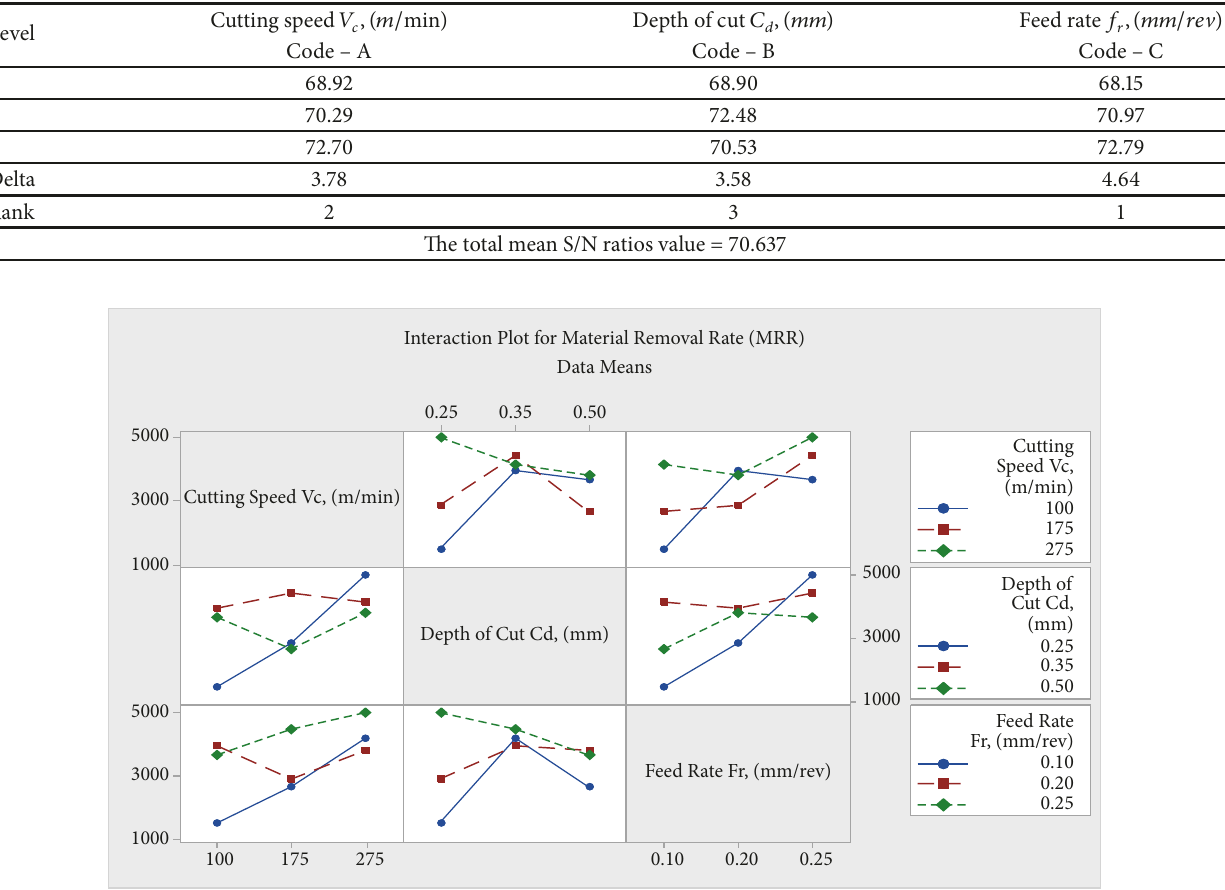
Figure 4: The main effect plot for S/N ratios data means for MRR (mm 3